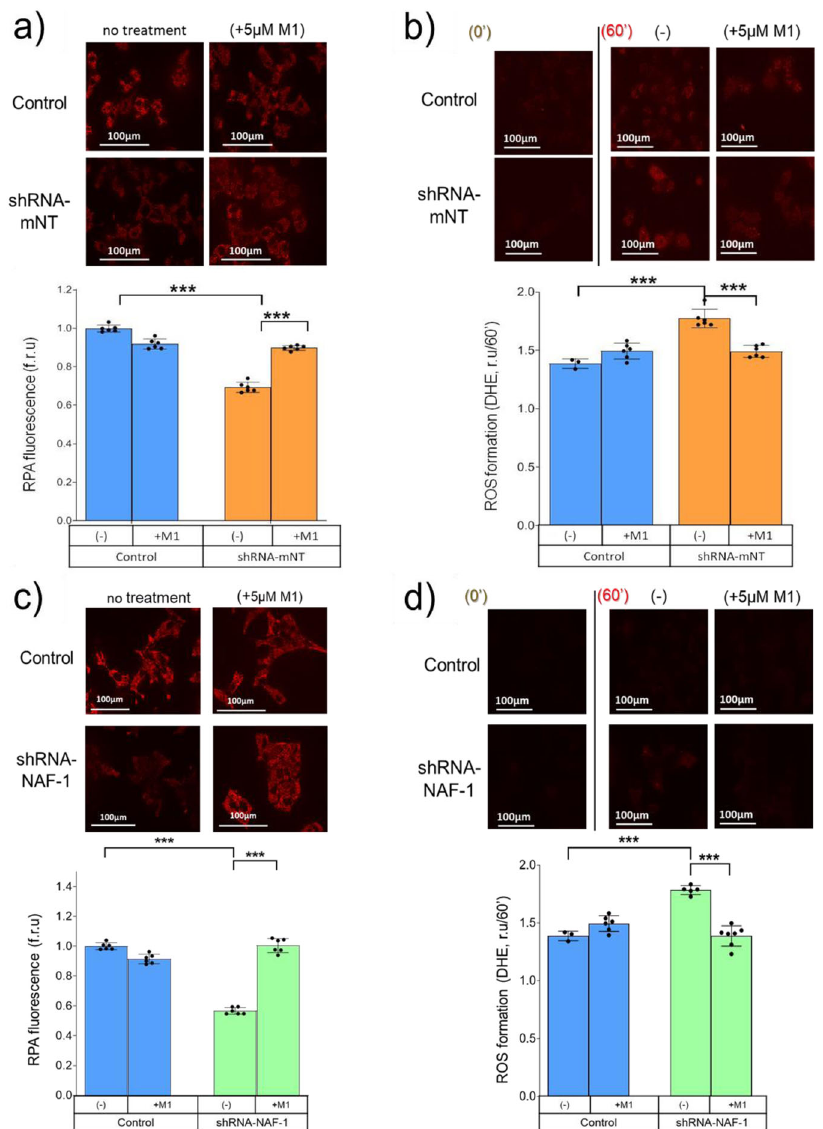
Fig. 2 M1 alleviates mitochondrial iron and ROS accumulation caused by reduced expression of mNT or NAF-1 in INS-1E cells. mLI levels of normal (control, INS-1E cells transfected with empty vector - blue bars) and INS-1 E cells with suppressed expression of mNT [shRNA-mNT ( a . orange bars)] or NAF-1 [shRNA-NAF-1 ( c green bars)] were assessed by the (rhodamine B-[(1,10-phenanthrolin-5-yl aminocarbonyl] benzyl ester) RPA probe. Upper panels: Semi-Confocal microscopic images of RPA fl uorescence in the mitochondria of control and INS-1E cells with reduced expression of mNT or NAF-1 following pretreatment of cells with or without 5 µ M of M1 for 30 min. Decreased RPA fl uorescence indicates increased mitochondrial labile iron. Lower panels: Quantitative analysis of RPA fl uorescence relative to untreated control cells following pretreatment of cells with or without 5 µ M M1 for 30 min prior to RPA addition. Mitochondrial ROS accumulation determined with the mitochondrial speci fi c mito-SOX TM probe. Upper panels: Epi- fl uorescence images of control (transfected with empty vector) and INS-1E cells with reduced mNT ( b ) or NAF-1 ( d ) expression following pre-treatment of cells with or without 5 µ M of M1 for 30 min. After the pre-treatment, ROS formation was detected over 60 min using mito-SOX TM . Lower panel: Quantitative analysis of mito-SOX TM fl uorescence change over 60 min incubation for treated or not treated cells with normal mNT protein expression (control/blue) and suppressed mNT expression cell (shRNA-mNT/orange) ( b ) or NAF-1 (shRNA-NAF-1/green) ( d ). Analysis was performed with (image J). ***Indicates P < 0.001, n =